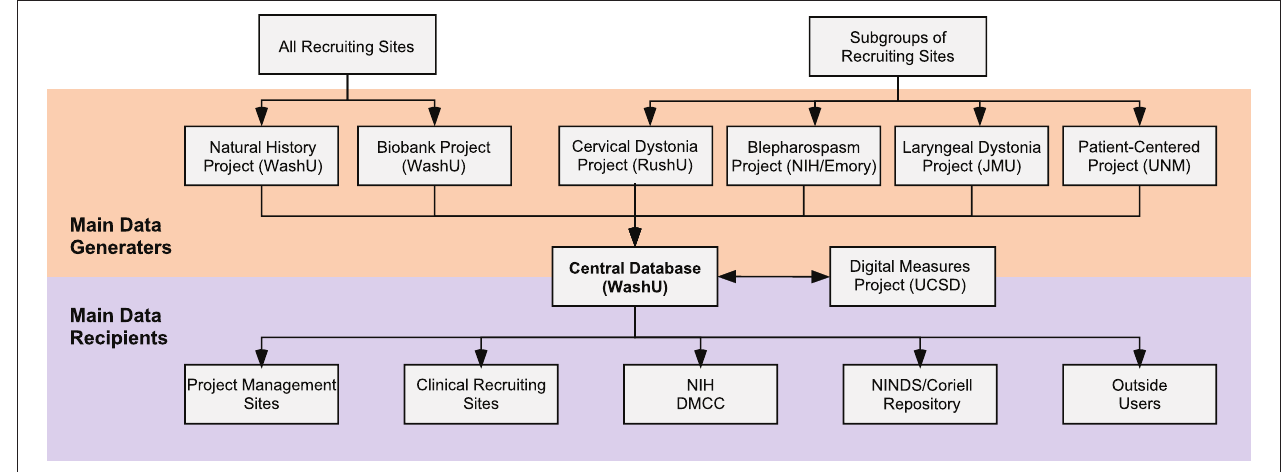
FIGURE 2 | Data collection and sharing. Data for large multicenter projects are organized by individual sites (orange) and collected into a central database for checking, storage, and distribution. All Recruiting Sites (top left) may recruit subjects for the Natural History Project and the Biobank Project. Subgroups of Recruiting Sites are selected to participate in the other large multicenter projects including the Cervical Dystonia Rating Scale Project, The Blepharospasm Diagnosis and Rating Scale Project, the Laryngeal Dystonia Diagnosis and Rating Scale Project, and the Patient-Centered Outcomes Project. The Digital Measures Project analyzes video data collected by all projects. Data submitted to the central database are verified and organized and returned to the sites who manage the large multicenter projects, and are also shared with multiple additional users. For example, Recruiting Sites may request a summary of data they entered. Data are also shared with the National Institutes of Health (NIH) and the Data Management and Coordinating Center (DMCC) of the Rare Diseases Clinical Research Network. Subsets of data are also shared with the National Institute of Neurological Disorders and Stroke (NINDS) Repository at Coriell and with other users by request. DMRF, Dystonia Medial